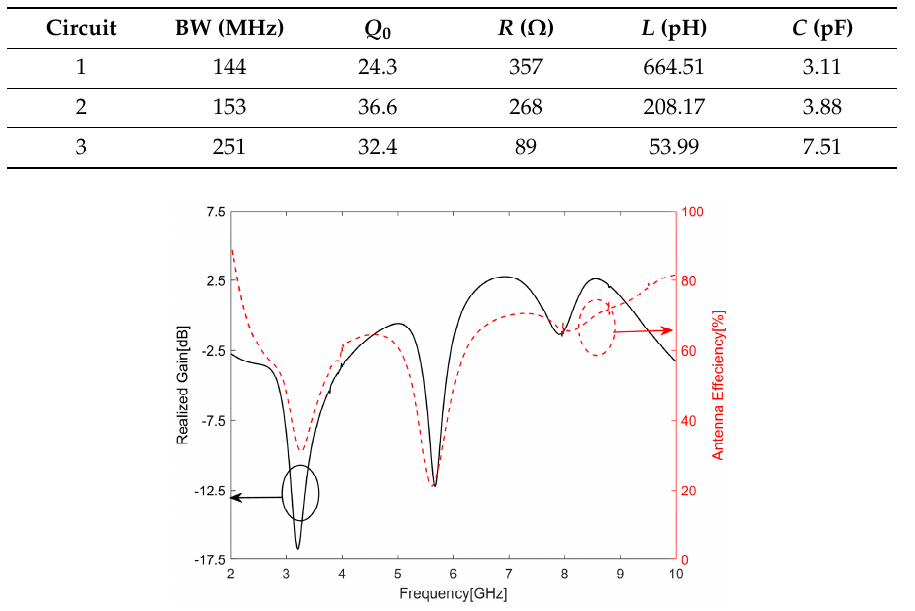
Figure 13. Realized gain and antenna efficiency of the proposed tri-band-notched UWB antenna. Information 2018 , 9 , x FOR PEER REVIEW